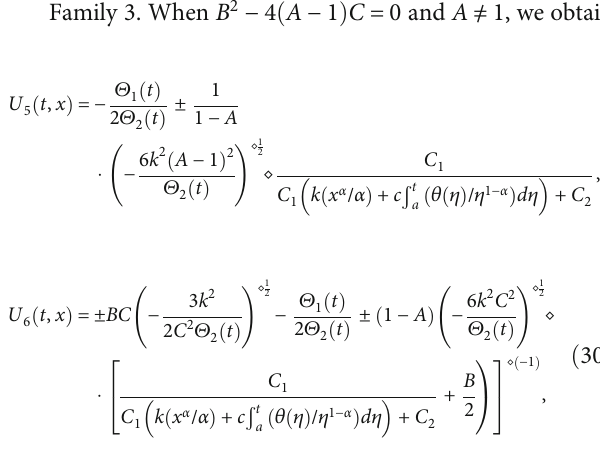
ð t , x Þ with A = 2, B = 1, C = 0, k = 1, c = 1, θ 1